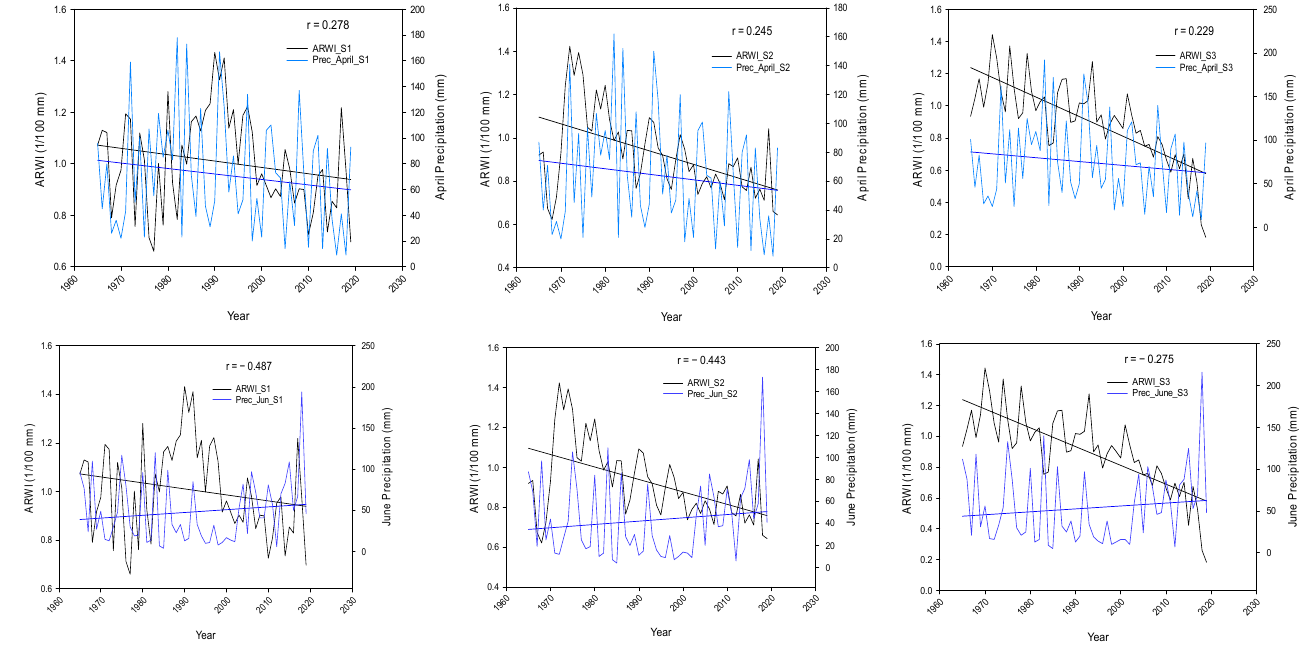
Figure 3. Graphical representation of the Average Ring Width Index against April and June Total Precipitation across the stands S1, S2, S3.